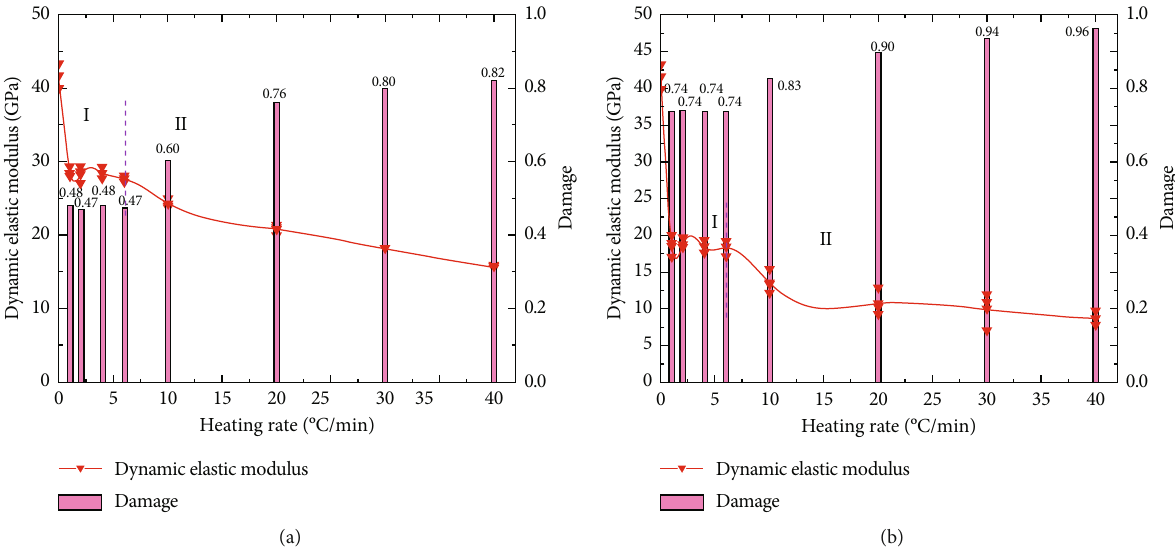
Figure 12: Damage e ff ect on the dynamic elastic modulus of thermal shock treated granite specimens (a) T = 400 ° C and (b) T = 600 ° C